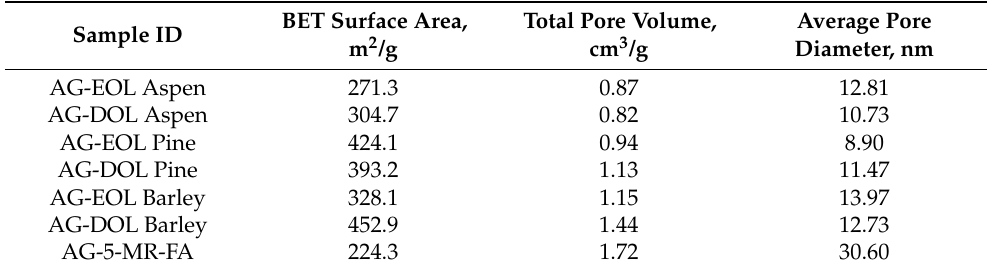
Table 4. The specific surface area, total pore volume, and average pore diameter of lignin-based (75% of the 5-MR was replaced by lignin) and 5-MR-FA aerogels. Sample